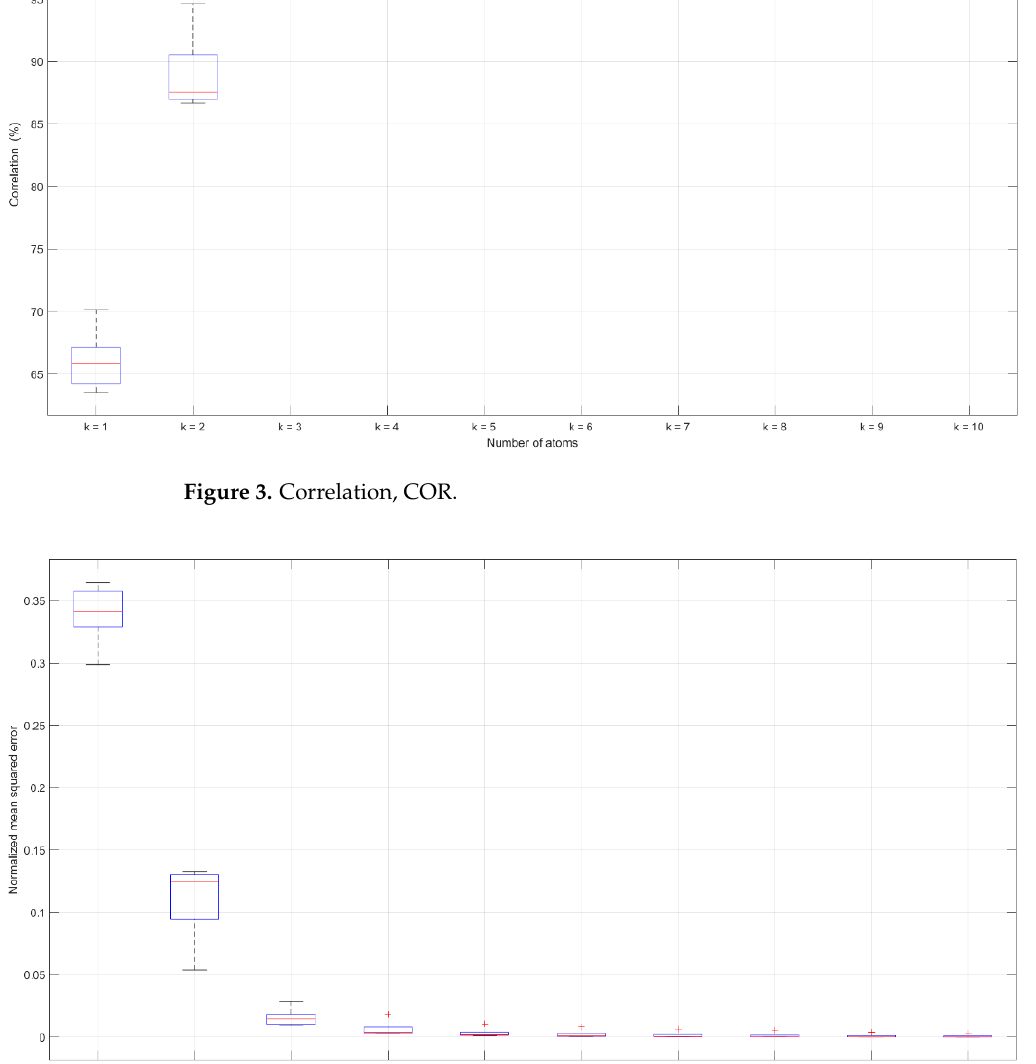
Figure 4. Normalized mean ‐ squared error NMSE. Table 1. Results summary.